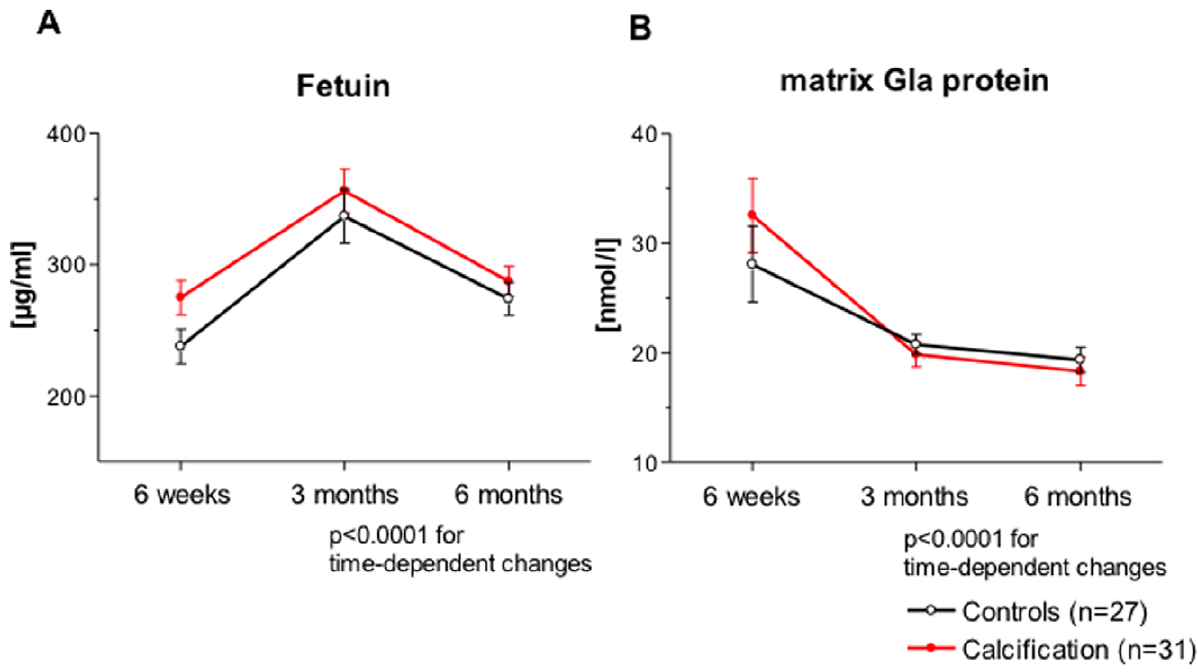
Figure 2. Serum concentrations of Fetuin A (A) as well as MGP (B) are shown in NC patients (n=31) in comparison to control transplant patients without signs of calcification (n=27) at the indicated time points. Patients with calcification are depicted in